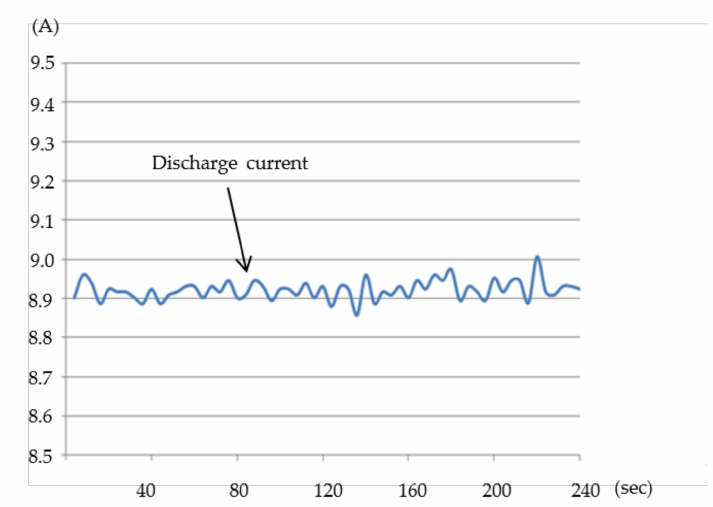
Figure 13. Discharge current value 9